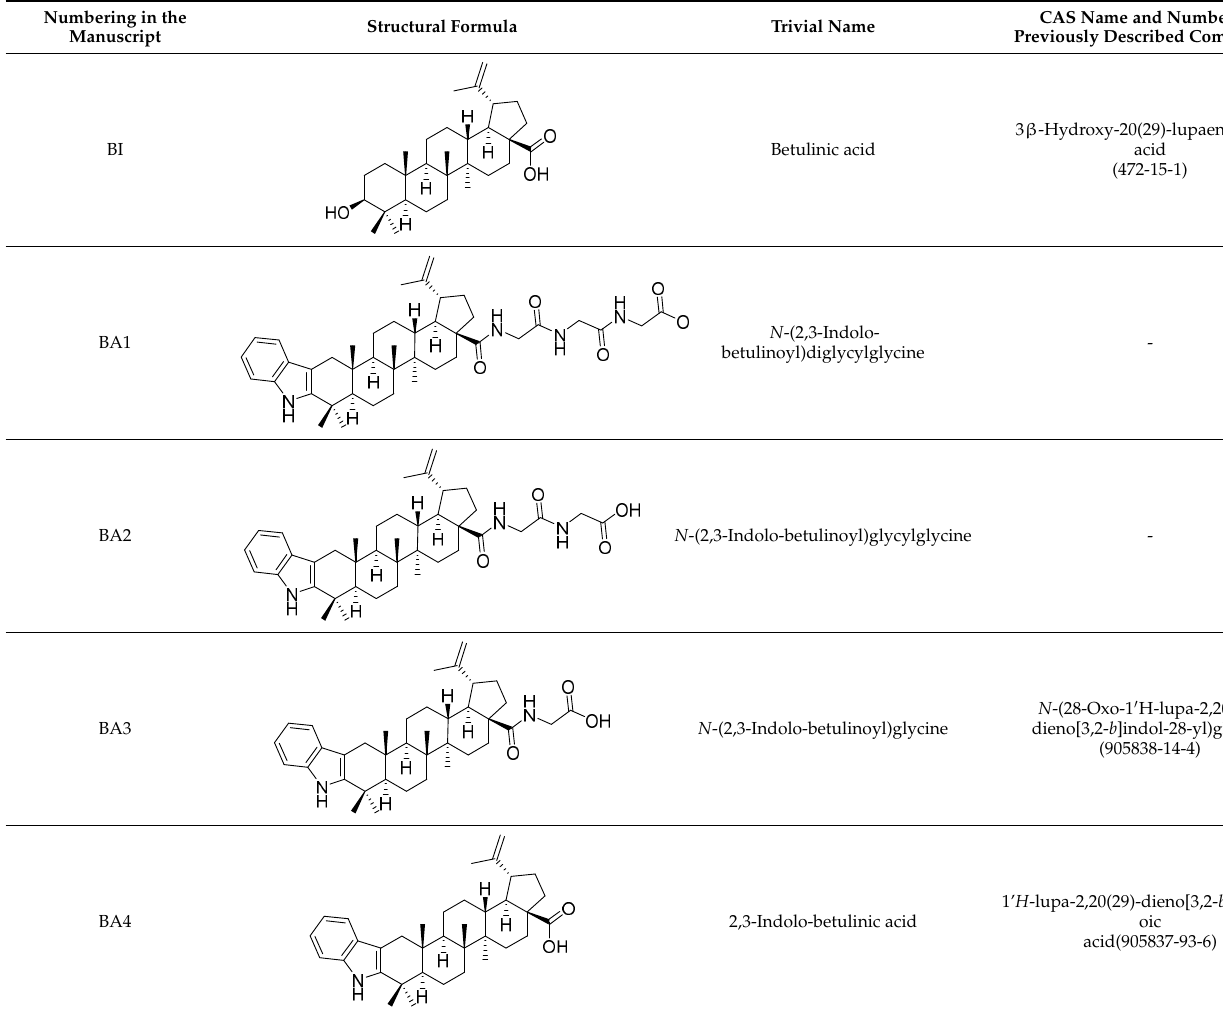
Table 3. Compounds used for the antimelanoma and antibacterial study.